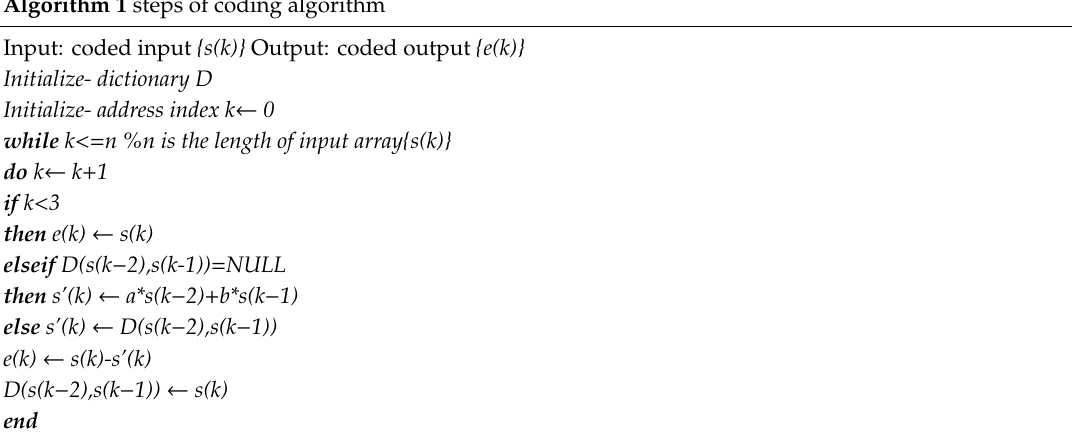
Algorithm 1 steps of coding